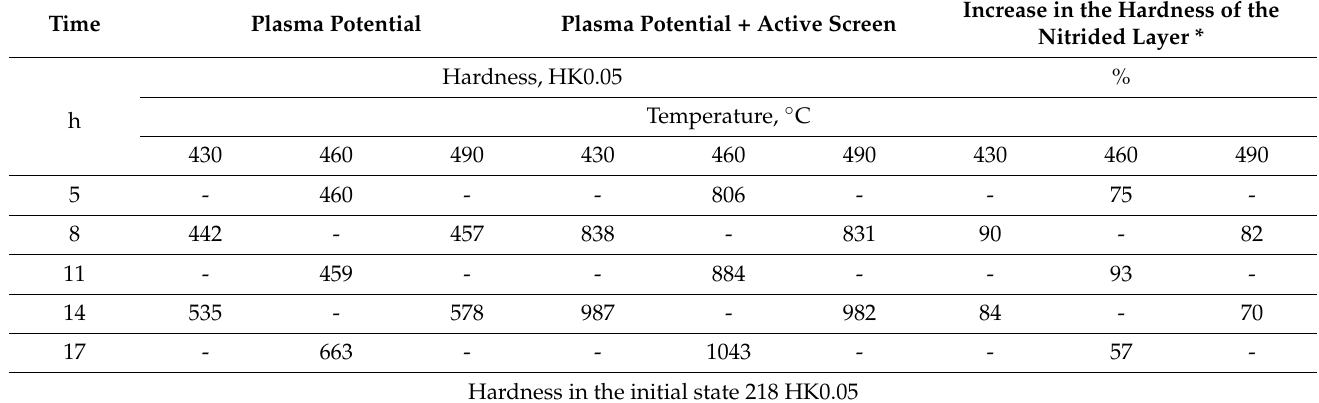
Table 5. Hardness of nitrided layers on the 316L steel substrate depending on the position of the samples in the glow chamber.